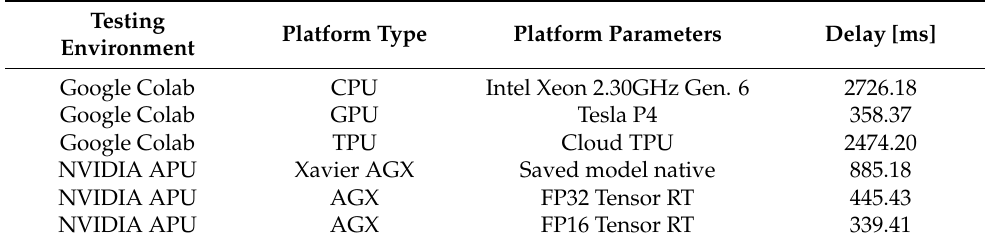
Table 2, for CNN Segmentation model Resnet101 and TensorFlow 2 with Pixelib in Table 3. Table 2. The acquired inference results for the SSD CNN model. Table 2. The acquired inference results for the SSD CNN